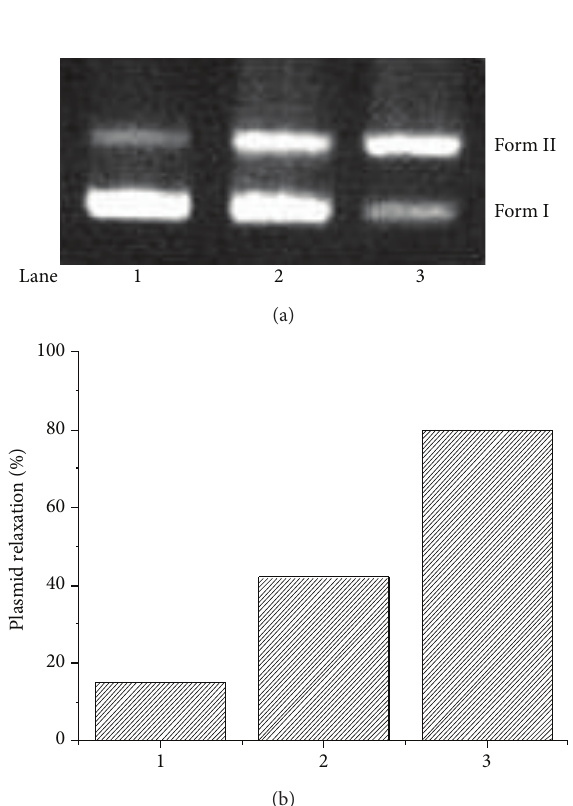
Figure 8: Effect of different compounds (100 𝜇 M) on the cleavage reactions of pUC 19 DNA (12.5 𝜇 g/mL) in a Tris-HCl buffer (100mM, pH 7.4) at 37 ∘ C for 4 h. (a) Agarose gel electrophoresis diagram: lane 1, DNA control; lane 2, ligand L ; lane 3, La (III) complex. (b) Quantitation of % plasmid relaxation (Form II %) relative to plasmid DNA per